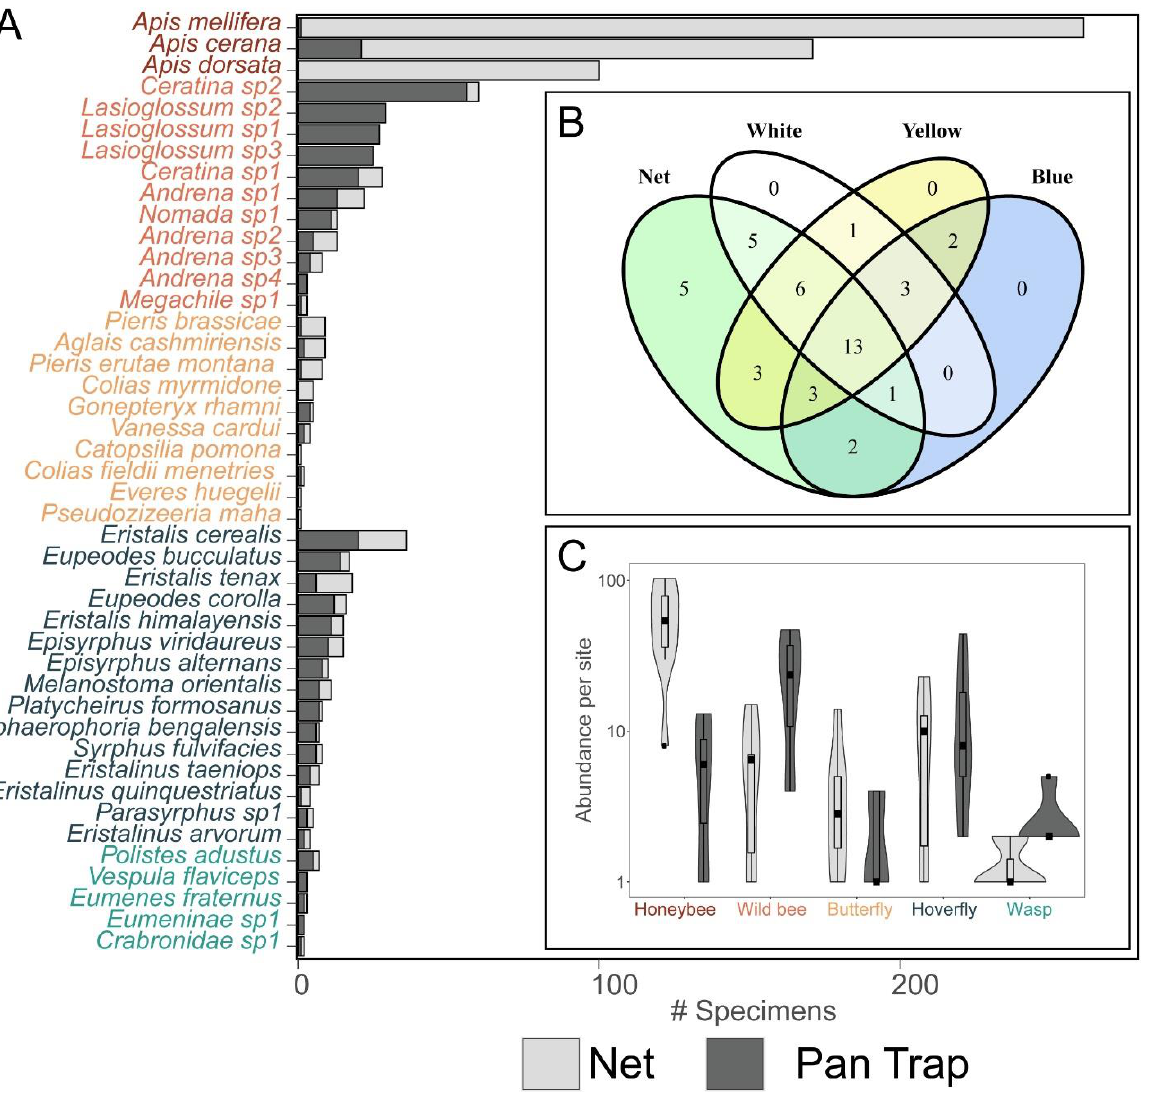
Figure 3. Overview of the complete inventory of pollinating insects found at each orchard. (A) Total number of specimens per (morpho-) species collected by netting or pan traps. The bars are stacked and represent the total number of (morpho-) species collected by both methods with the dark grey bar showing total (morpho-) species collected by pan traps and light grey total netted (morpho-) species. (B) Species richness shared by each collection method. Colours refer to the colours of the pan traps used. (C) Total abundance for each of the major insect groups by netting or pan